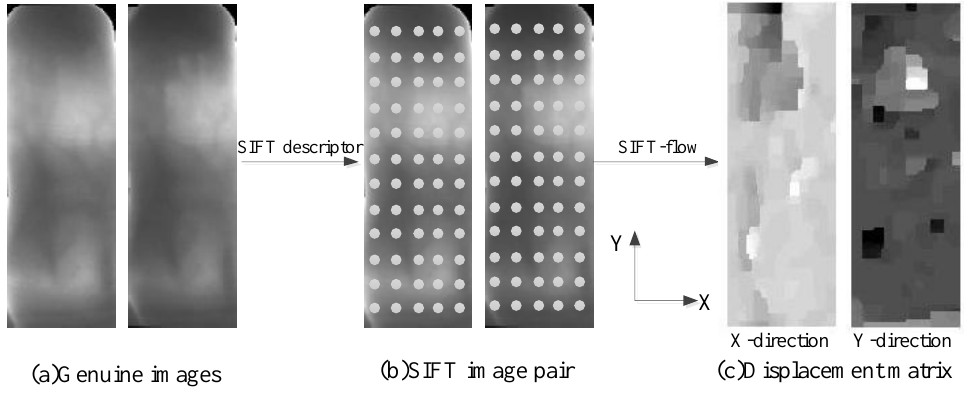
Figure 3. The process of obtaining the displacement